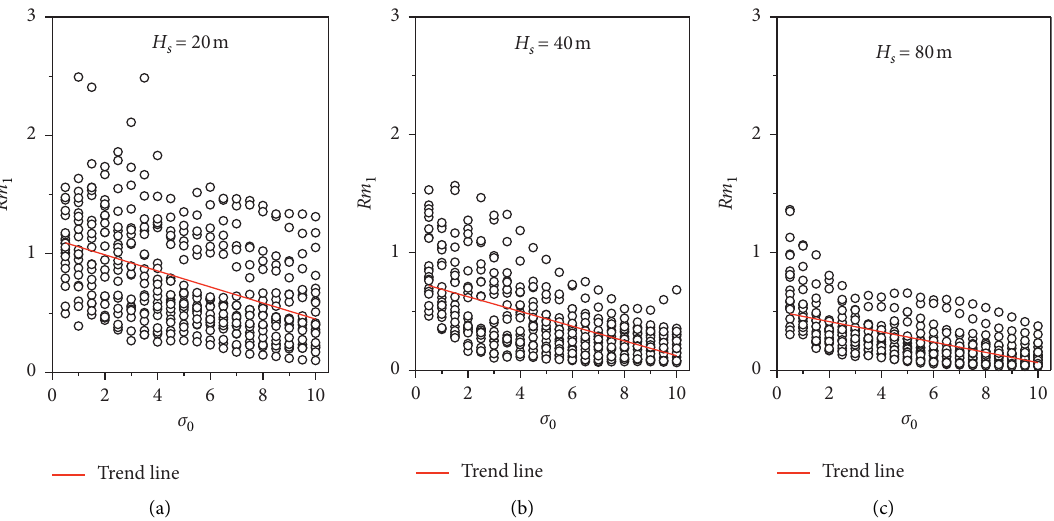
l � 0.2 and c � 0.5. 0 0